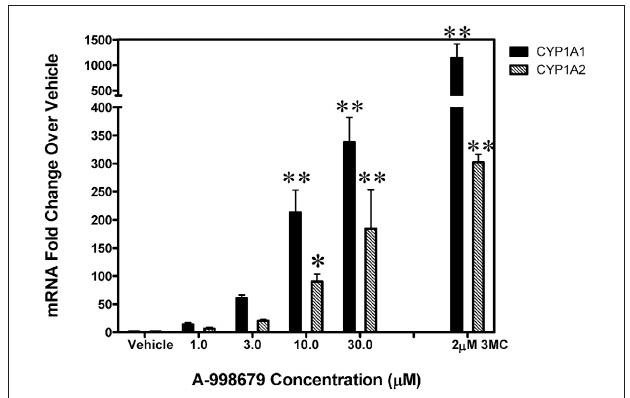
FIGURE 5 | CYP1A1 and CYP1A2 levels in primary human hepatocytes dosed with increasing levels of A-998679. The x-axis represents concentration ( μ M), and the y-axis shows fold-change in CYP1A1 and CYP1A2 mRNA (average ± SD) relative to vehicle control treated cells. 3MC (2 μ M) served as a positive control. The black bars represent CYP1A1 and the gray shaded bars indicate CYP1A2. Marked bars indicate that the values were significantly different between treated and vehicle control hepatocytes ( ∗ p < 0 . 05, ∗∗ p < 0 . 001).